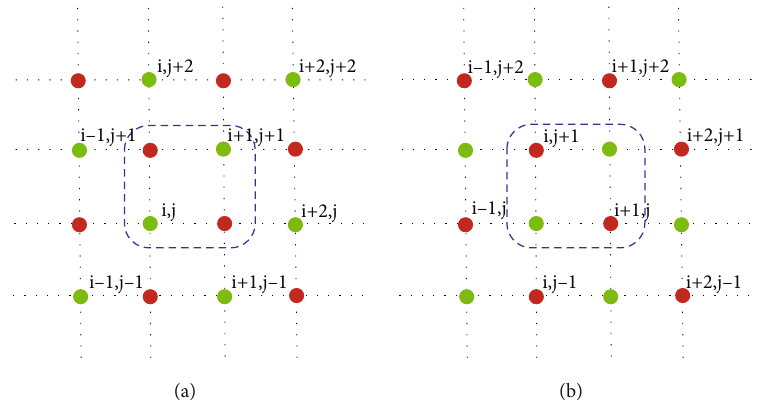
Figure 1: Grid point on x − y plane. Computational molecule of Equation (27) (a) and computational molecule of Equation (28)